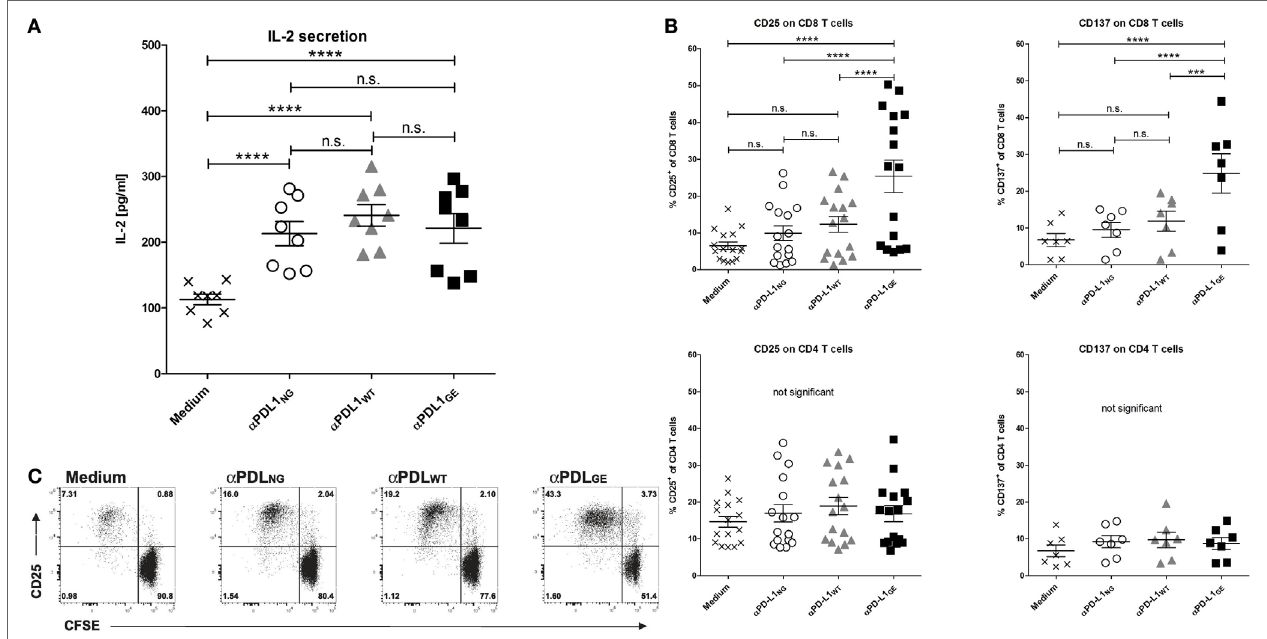
FigUre 4 | Glyco-engineered anti-human programmed death-ligand 1 (PD-L1) antibody induces strong CD8 T cell activation in a mixed leukocyte reaction. The three anti-PD-L1 variants α PDL1 NG (open circles), α PDL1 WT (gray triangles), and α PDL1 GE (black squares) were tested for their effect on T cell activation in a mixed leukocyte reaction (MLR). The medium control (black crosses) served as a negative control. T cells as responder cells were isolated from a single healthy donor (donor A). Monocyte-derived dendritic cells as stimulator cells were generated from different healthy donors. (a) IL-2 enzyme-linked immunosorbent assays on day 2 of MLR. The determined concentrations of IL-2 in the culture supernatants were plotted. (B) The activation status of CD8 and CD4 T cells in the MLR was determined on day 5 by flow cytometric analysis. The relative frequencies of CD25 + and CD137 + in CD8 and CD4 T cells were plotted. (c) The proliferation of CFSE-labeled CD8 T cells in the MLR was determined on day 5 by CFSE dilution measured by flow cytometric analysis. Representative plots of CD25 expression and CFSE signal intensity of CD8 T cells are shown. Statistics for (a,B) : besides individual data points ( n = 8 for IL-2 secretion, n = 16 for CD25 expression, and n = 7 for CD137), mean and SEM were plotted in all graphs (* p < 0.05; ** p < 0.01; *** p < 0.001; and **** p < 0.0001. Abbreviation: ns, not significant).